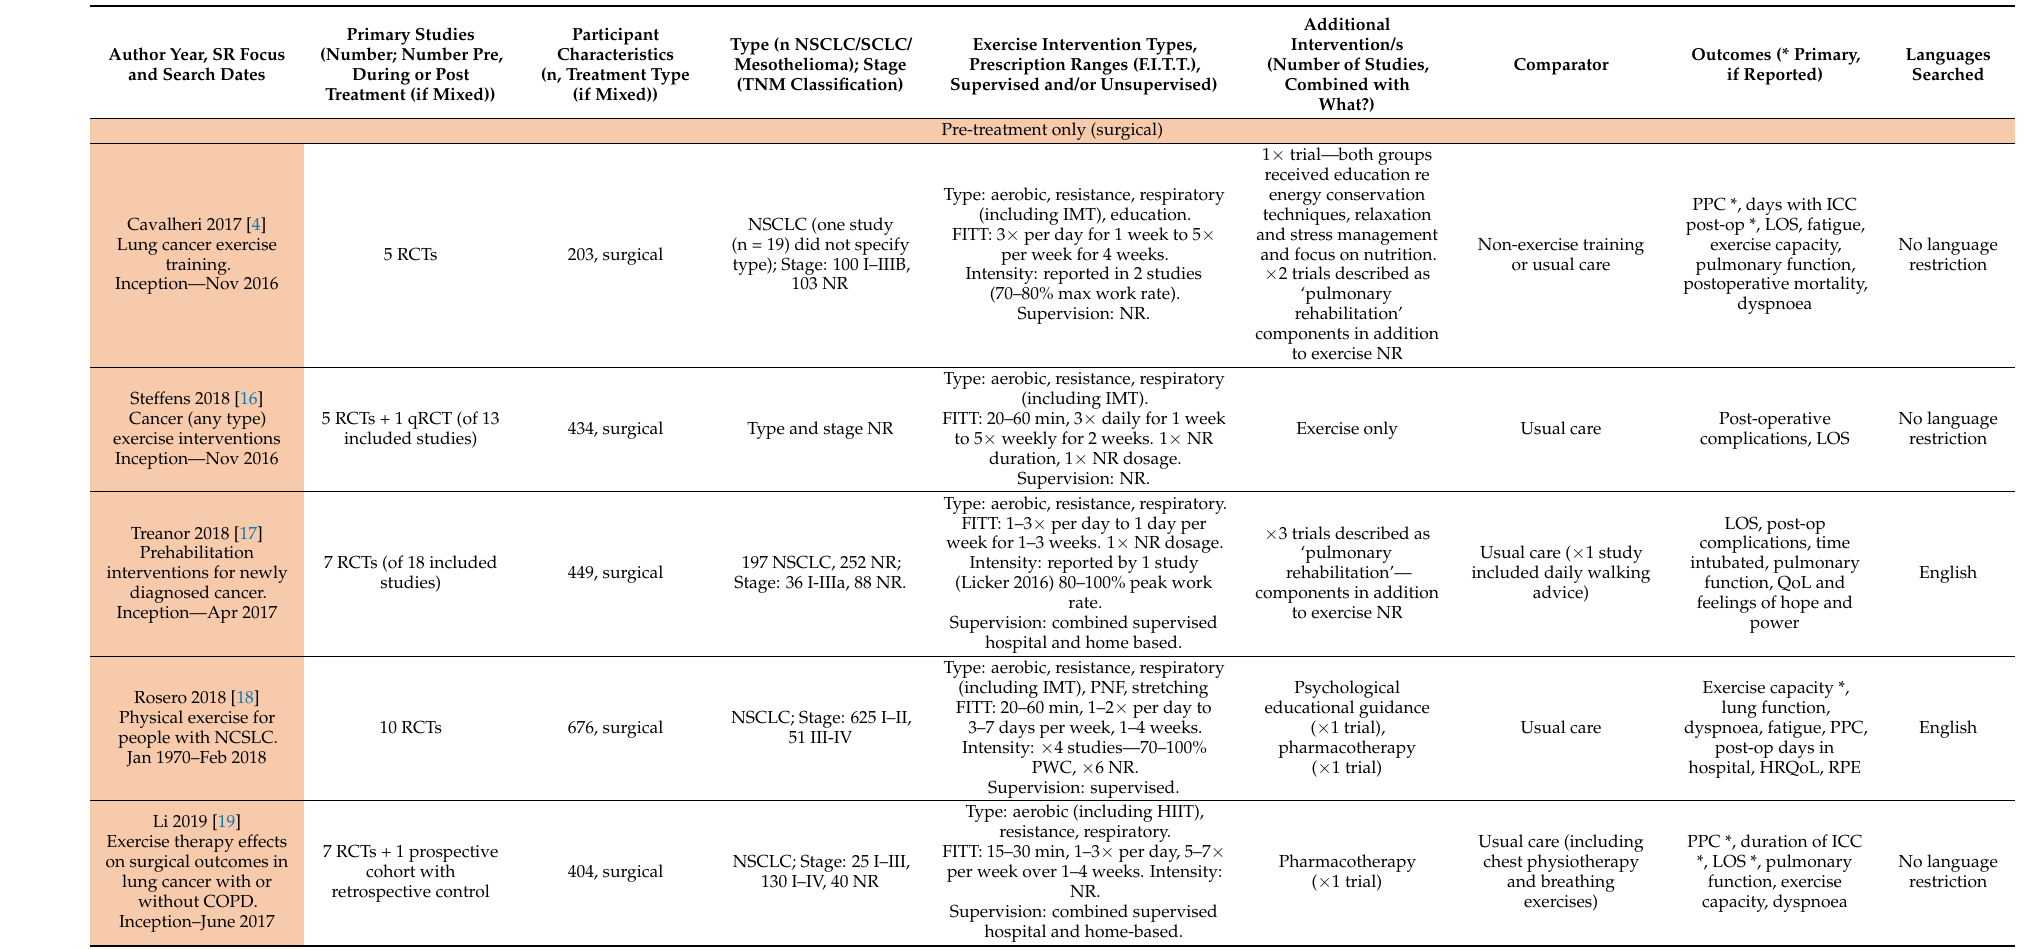
Table 1. Characteristics of included